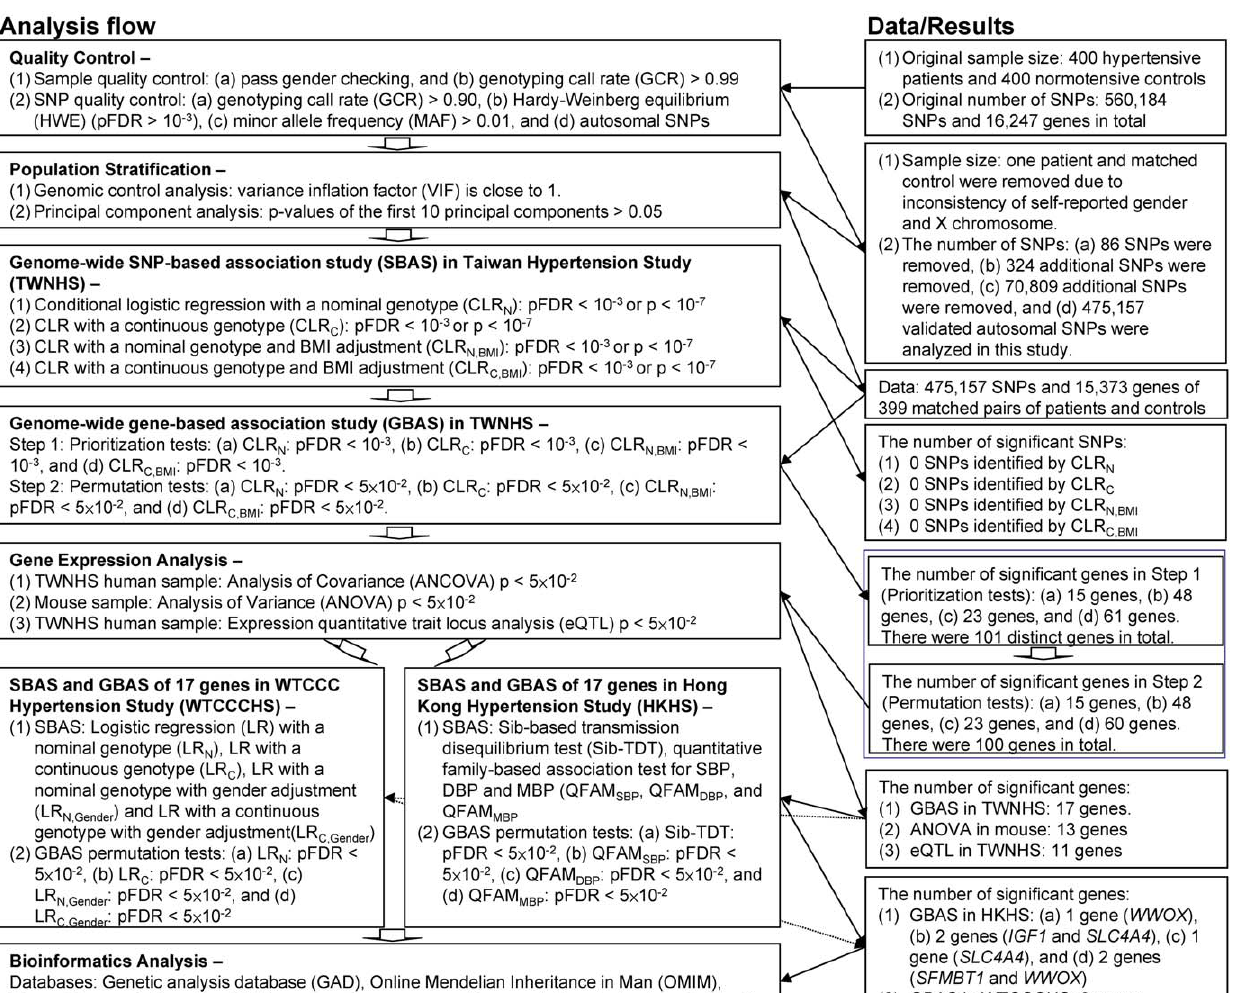
Figure 1. An analysis flowchart of this study.